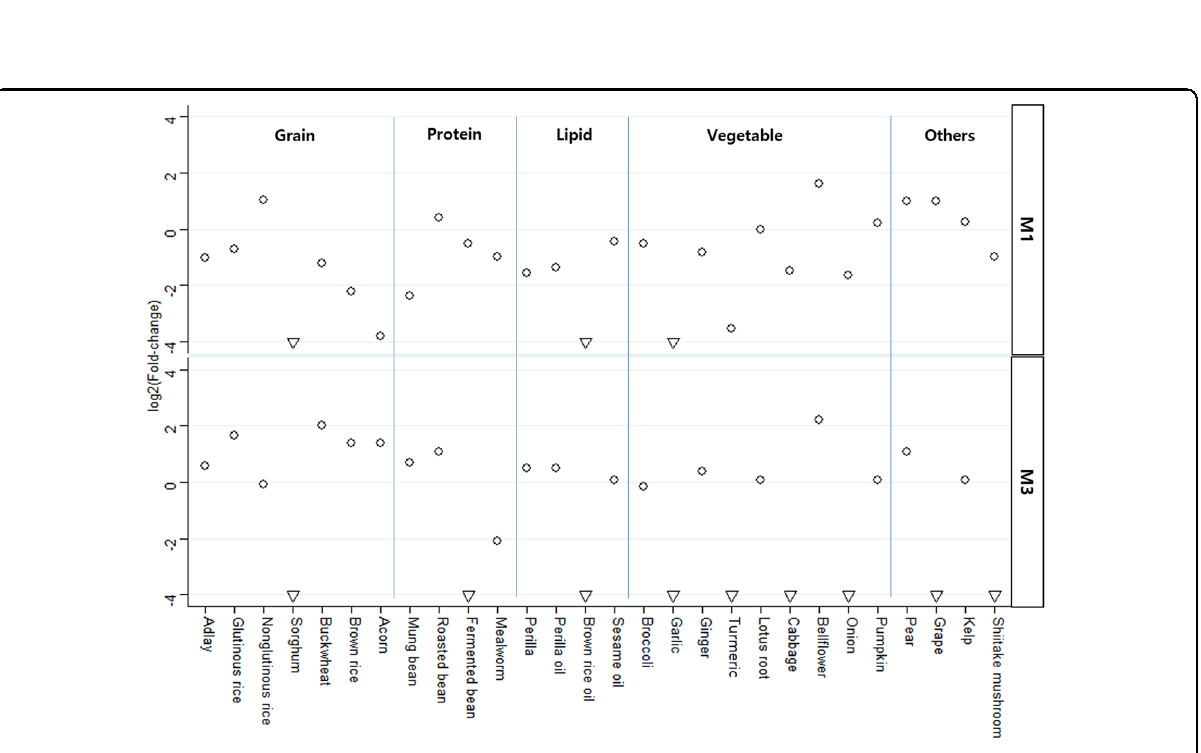
Fig. 7 Fold-change in brain tumor (BT) risk between high fat diet (HFD) and HFD + fed mouse groups. The M1 (stepwise selection) and M3 (LEfSe) BT diagnostic models developed in this study were applied to mice fed either an HFD or an HFD with an additional food item (HFD + ). The fold-change of the fi tted value of BT risk between the HFD and HFD + groups was plotted for each dietary food as well as each diagnostic